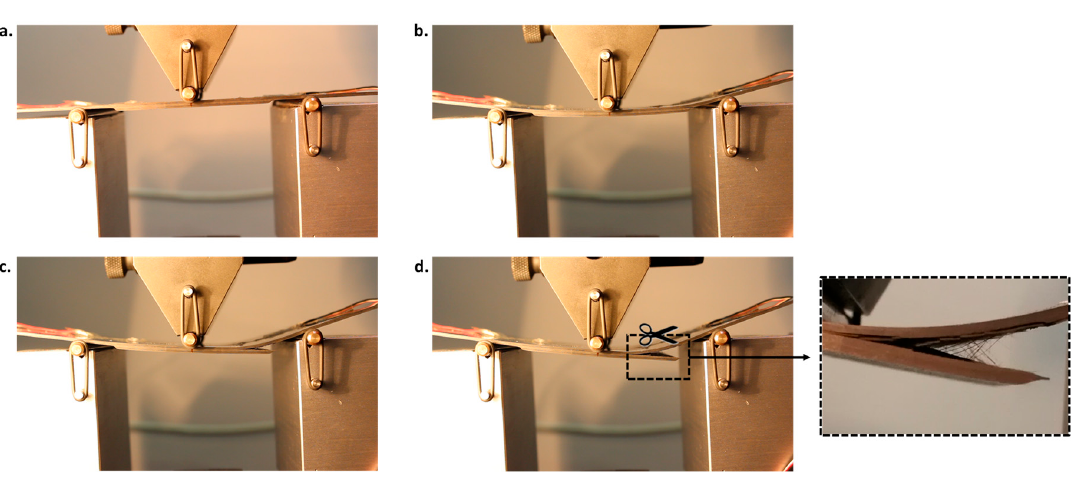
Figure 10. Experimental Load vs. Applied displacements in ( a ) low bridging sensitivity case, ( b ) high bridging sensitivity case; ( c ) max loads comparison. LB: low bridging; HB: high bridging.